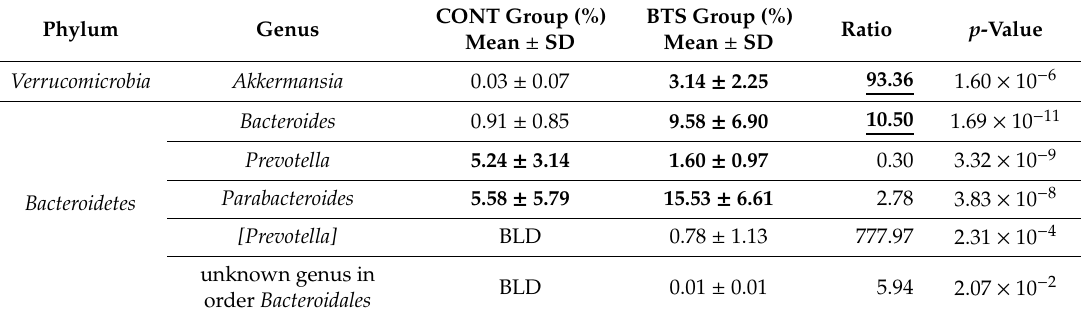
Figure 5. Non-metric multidimensional scaling of stool microbiota in ob / ob mice fed a diet with or without BTS. Similarity of microbiota between CONT and BTS was assessed by non-metric multidimensional scaling (NMDS). Circle, stool sample; Cross, detected genera; Bold cross, genera showing significant di ff erences with 10-fold changes between CONT and BTS groups in Table 2. The limb of each group is shown by a dotted line. The dissimilarity test between CONT and BTS was performed by permutational multivariant analysis of variance test. Table 2. Relative abundance of microbiota (genus level) throughout administration of 5% BTS in ob / ob mice.